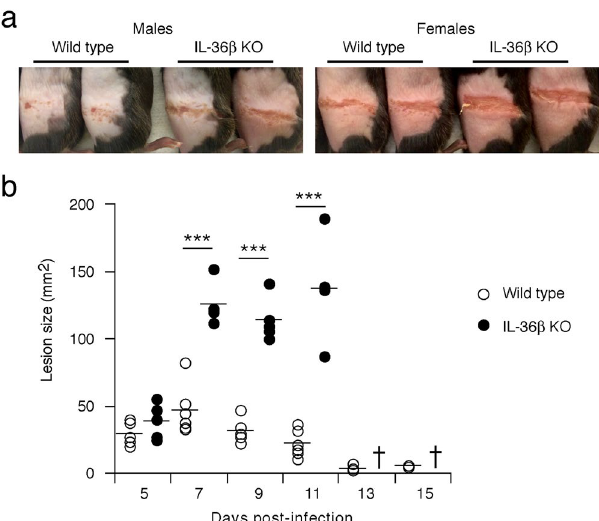
Figure 7. IL-36 β deficient mice develop more severe secondary zosteriform skin lesions. ( a ) Wild type and IL- 36 β KO mice were infected with HSV-1 as described in Fig. 2. Male and female wild type and IL-36 β KO mice were anesthetized and photographed at day 6 post-infection. ( b ) Wild type (open circles, n = 6) and IL-36 β KO (black circles, n = 5) mice were infected with HSV-1 as described in Fig. 2 and progression of secondary zosteriform lesions photo-documented for 15 days as illustrated in a and Fig. 2. Lesions were sized using ImageJ. †, all mice dead; *** p <